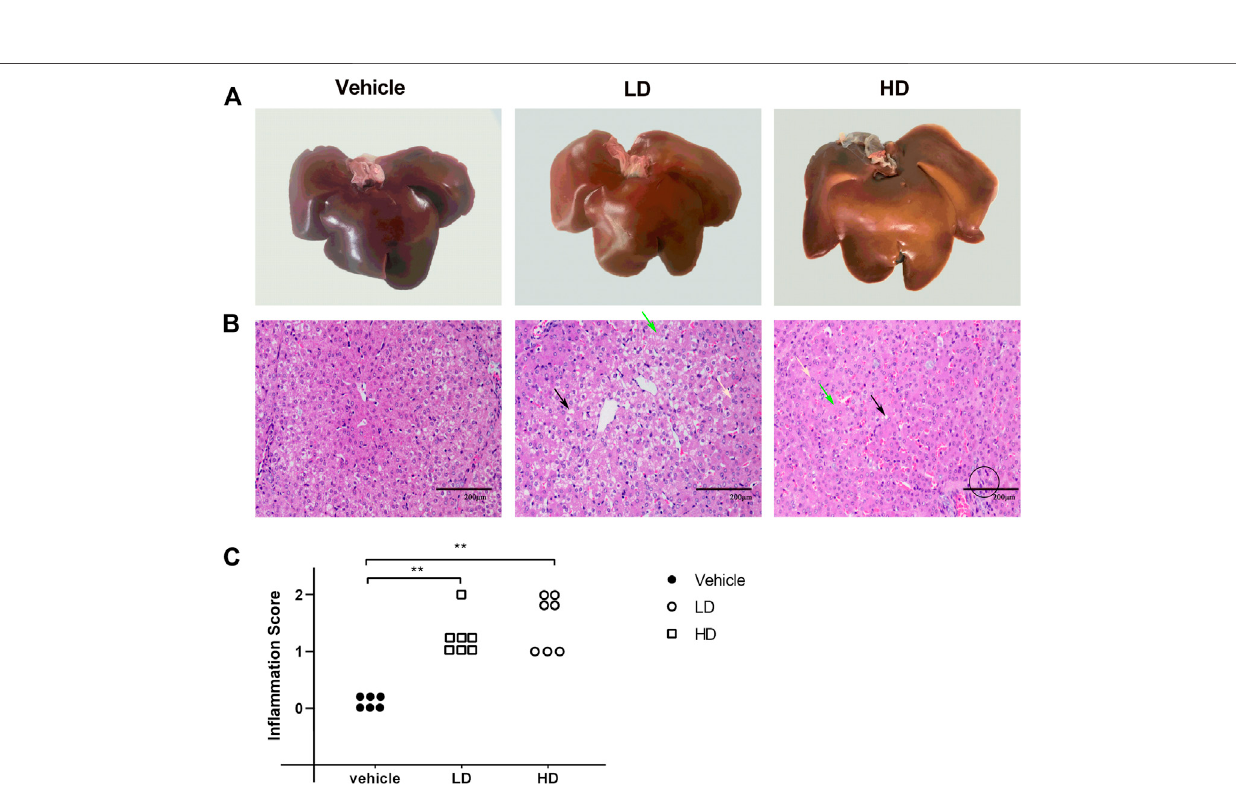
Frontiers in Physiology |